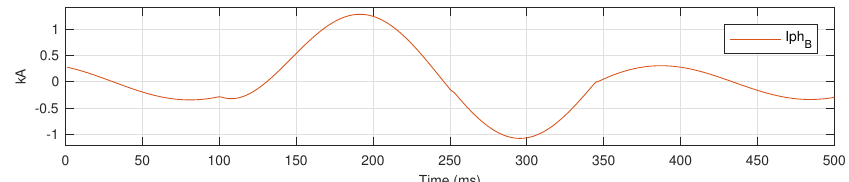
Figure 10. Iph B for a bolted LG fault on phase B in AUTO mode. In Figure 10, the max value of the Iph B is 1.2775, while | ¯ x | is 0.0108. For the above case, the value of MF is 117.7036. For the no fault case, the max value of the Iph B is 0.343, while | ¯ x | is 0.026, resulting in MF of 13.273. The difference in MF of Iph B for NF and LG-B fault cases is shown in Figure 11.